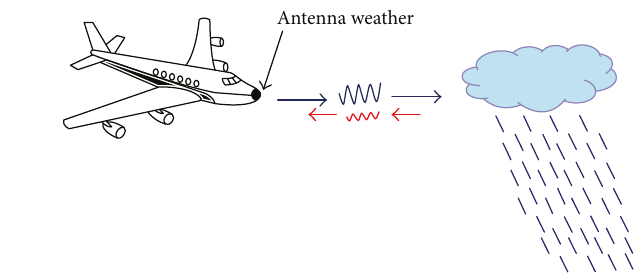
Figure 1: The aircraft weather